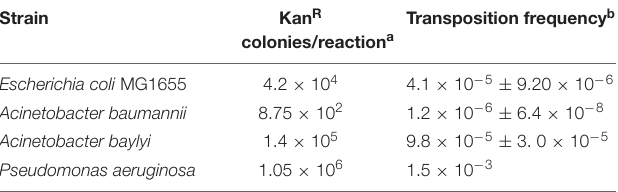
TABLE 6 | mini-ISY100-LP transposition frequency in different species. Transposition frequency b Strain Kan R colonies/reaction a